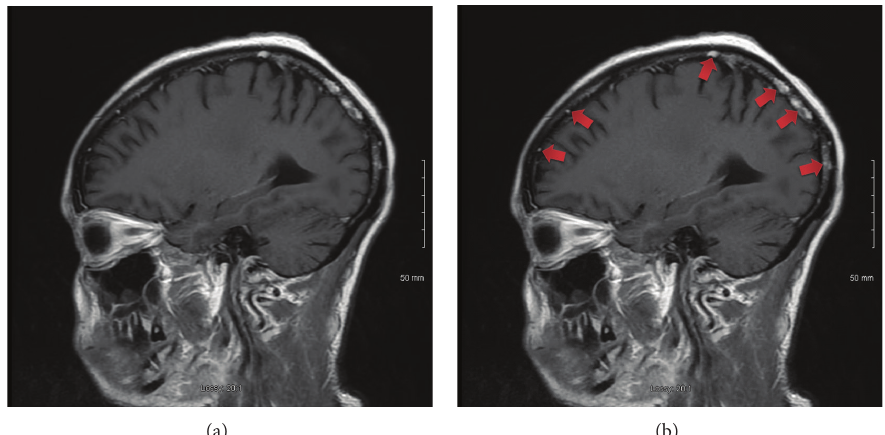
Figure 3: MRI of the brain revealed scattered subcortical T2-hyperintense foci and enhancing nodules in the calvarium (indicated by red arrows), consistent with metastatic